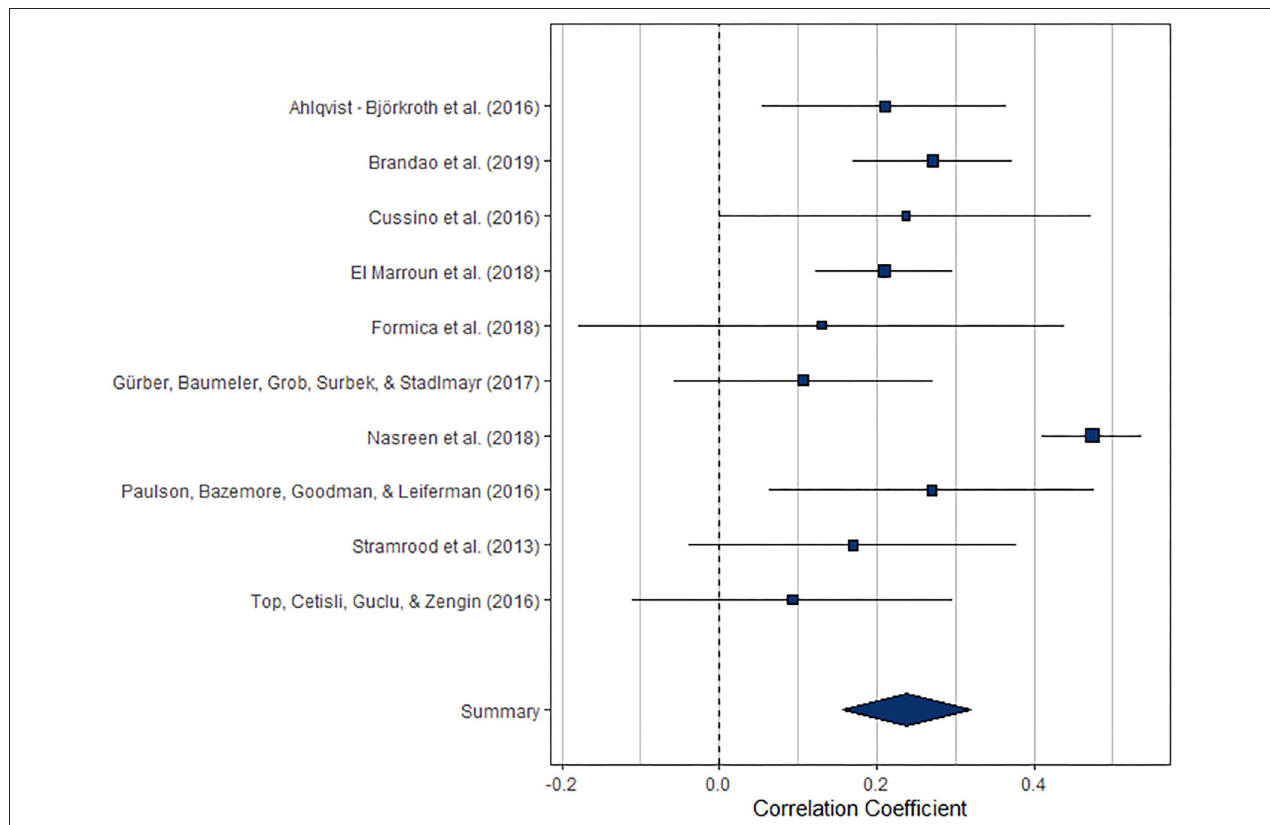
FIGURE 2 | Forest plot of the analysis of the association between paternal and maternal depression during the prenatal period. Weighted effect size and 95% CI are presented on the right.